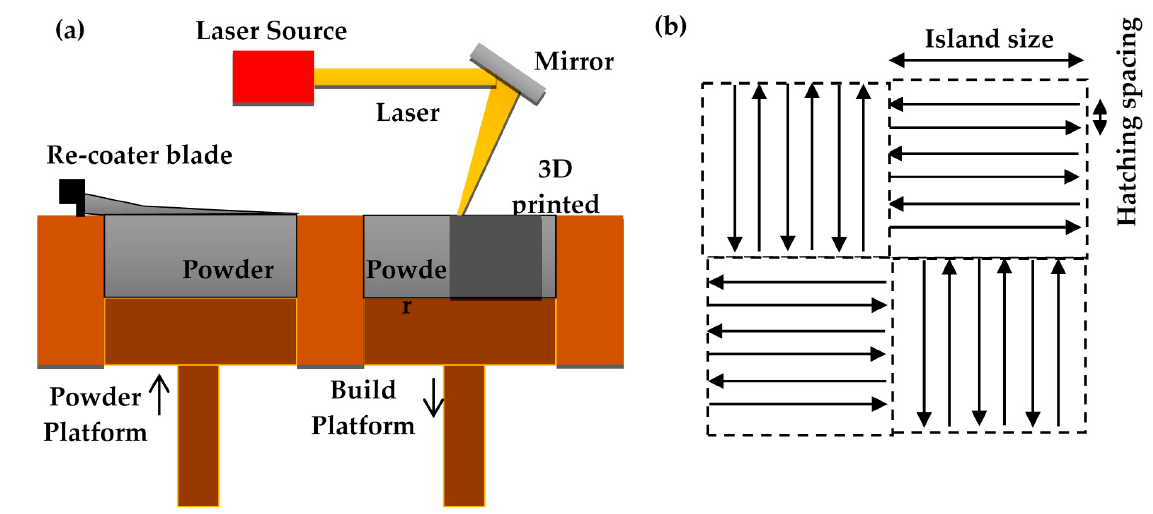
Figure 2. ( a ) A schematic diagram of the laser powder bed fusion system, ( b ) the island scanning and hatching spacing contours.